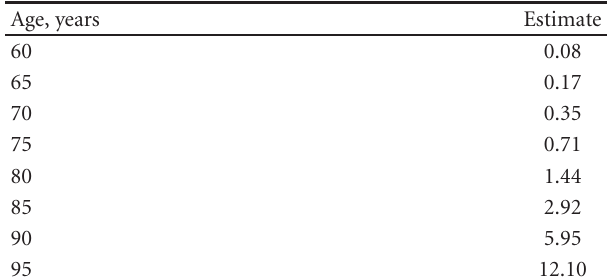
Table 1: Age-specific incidence rates for Alzheimer’s disease. Mean estimates are the averages of the smoothed age-specific incidence curves from these studies